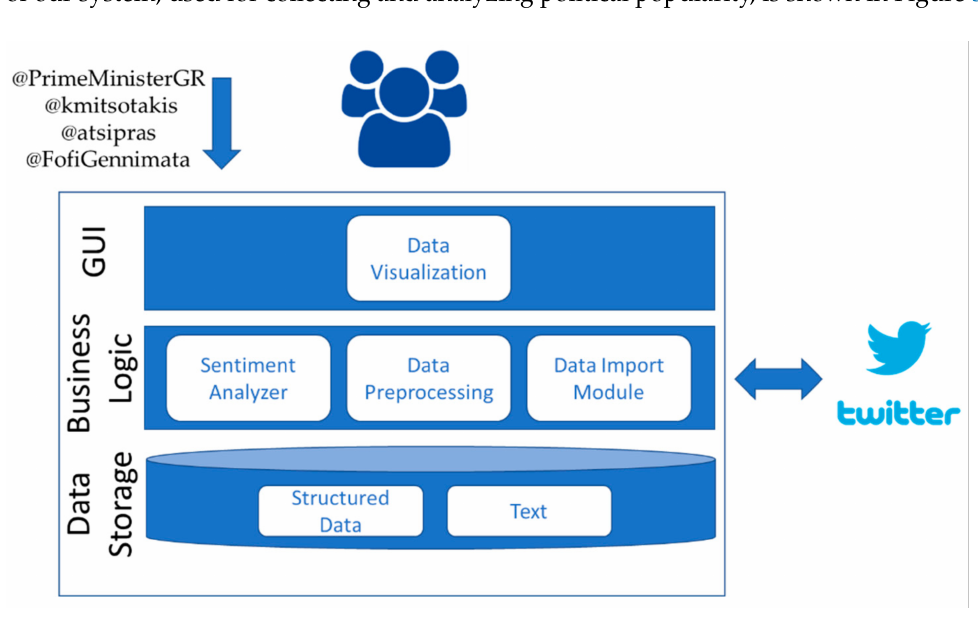
Figure 3. High-level architecture of the AthPAA